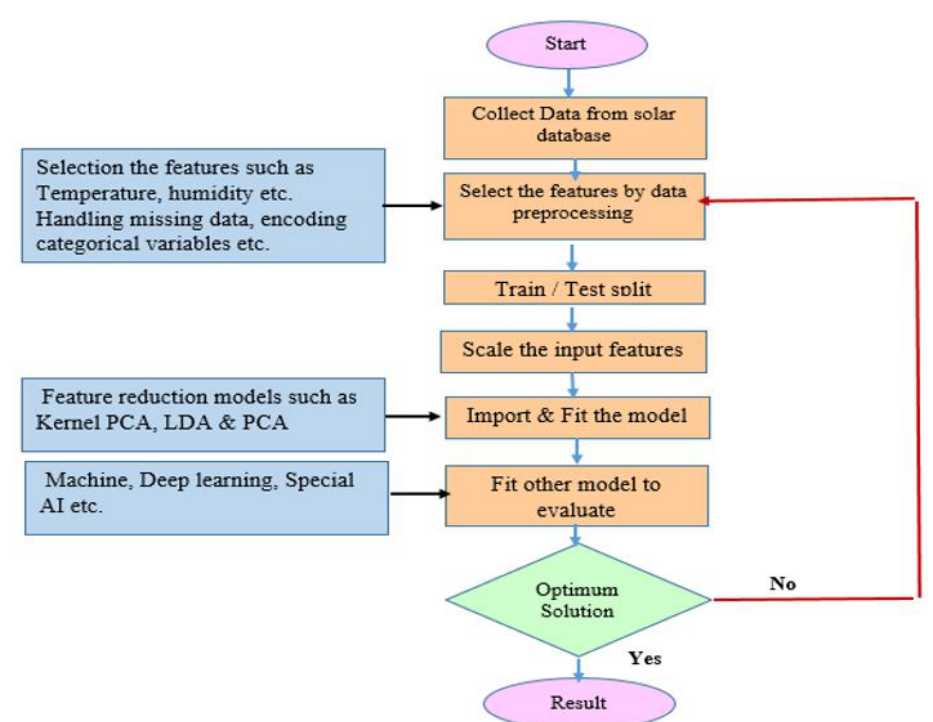
Figure 9. Flow chart for feature reduction based unsupervised models.